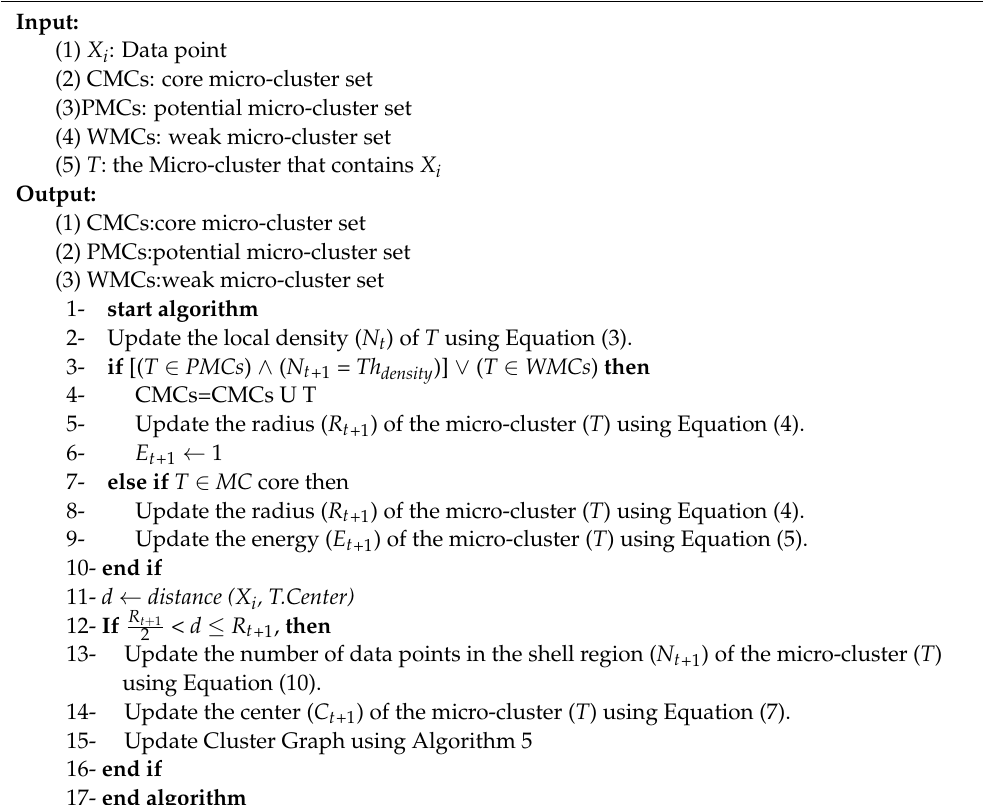
Algorithm 4: BOCEDS Micro-Cluster